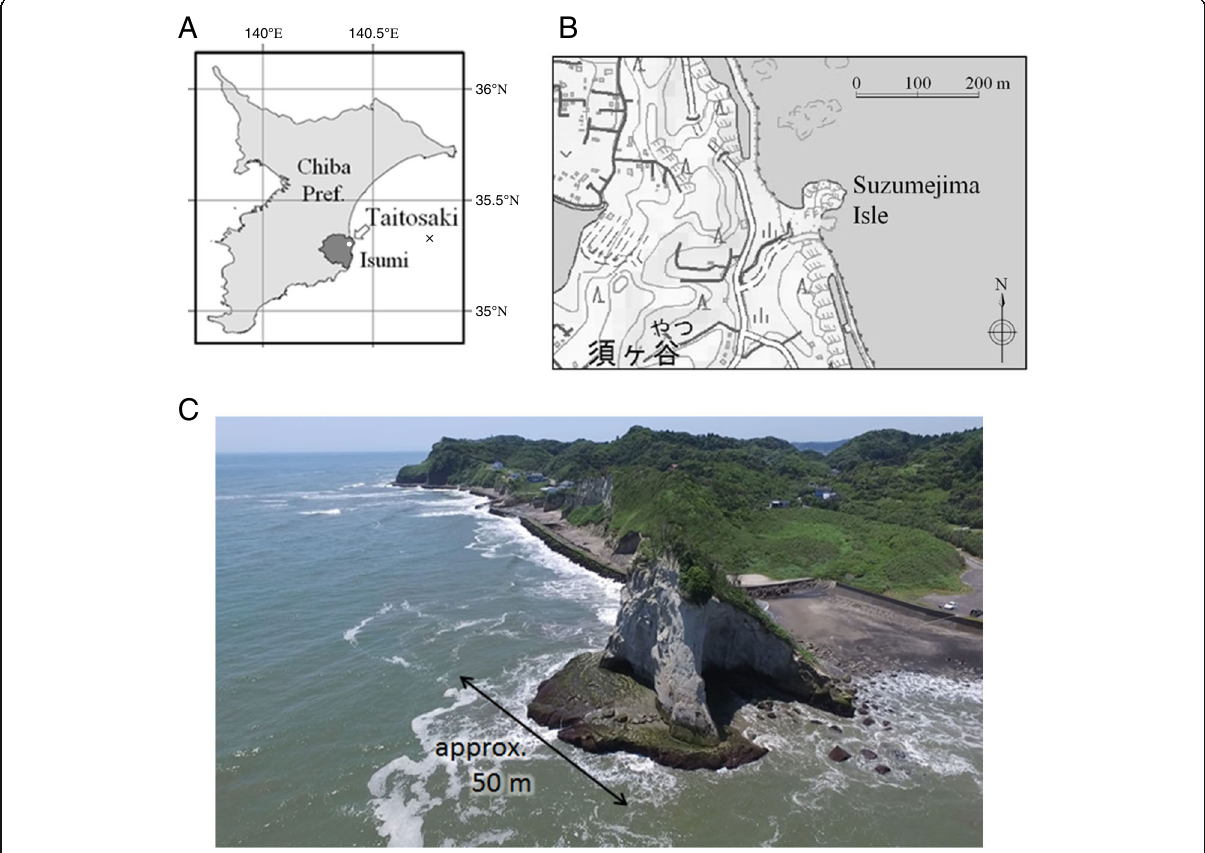
Fig. 1 Location map of the study area ( a , b ) and aerial photograph ( c ) taken by the UAV camera from the north. In a , the white circle is the location of the seismic observation point and the x-mark is the location of the wave observational